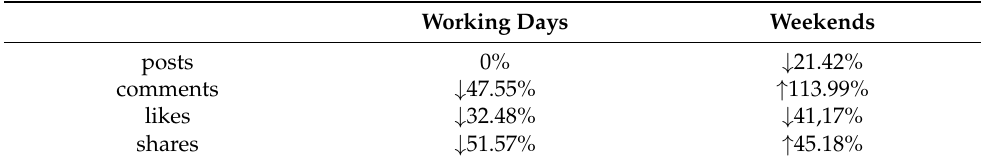
Table 7. Comparison of the absolute changes in the mean value (median).